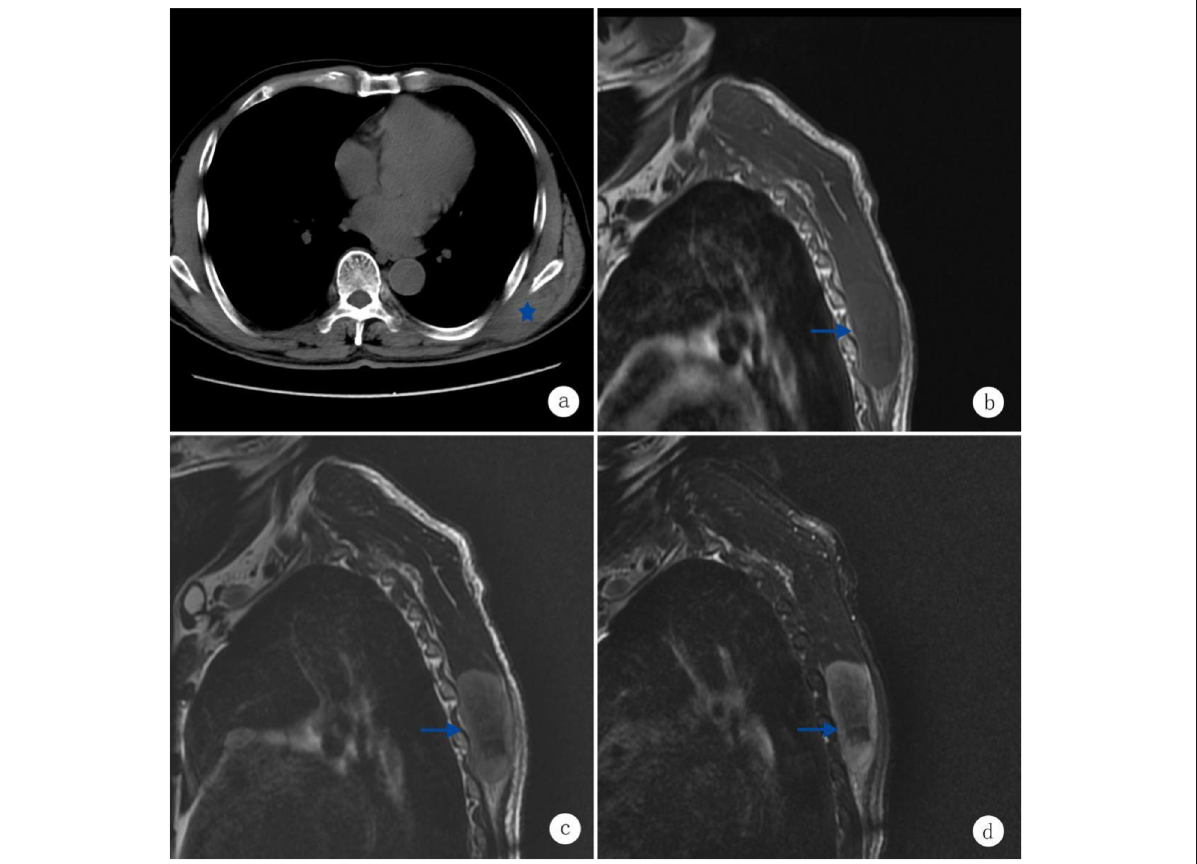
Fig. 1 Imaging examination. a CT revealed an irregularly shaped soft tissue mass 7.0 cm × 5.4 cm × 2.7 cm in size in the left thoracic and dorsal muscle space, and the mass showed a clear boundary and uniform density. b MRI confirmed the presence of an irregularly shaped soft tissue mass in the left thoracic and dorsal muscle space with long T1. c T2 signals, as well as a uniform low signal on T1WI. d a high signal with fat suppression on T2WI. The blue five-pointed star and arrow indicate the